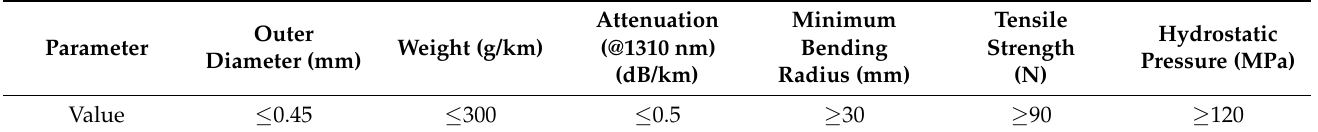
Table 7. The parameters of the fiber optic cable.